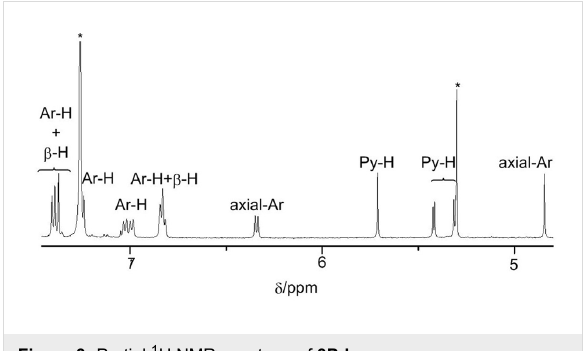
Figure 3: Partial 1 H NMR spectrum of 3Pd